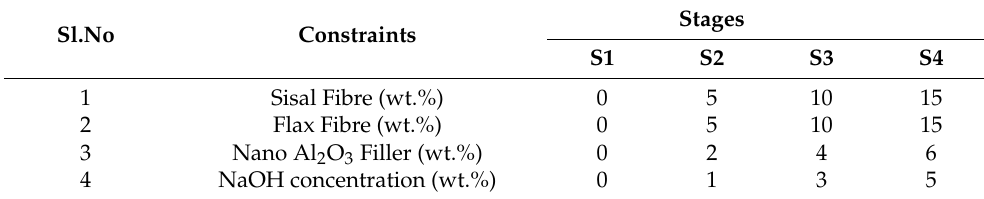
Table 1. Constraints and their stages for hybrid